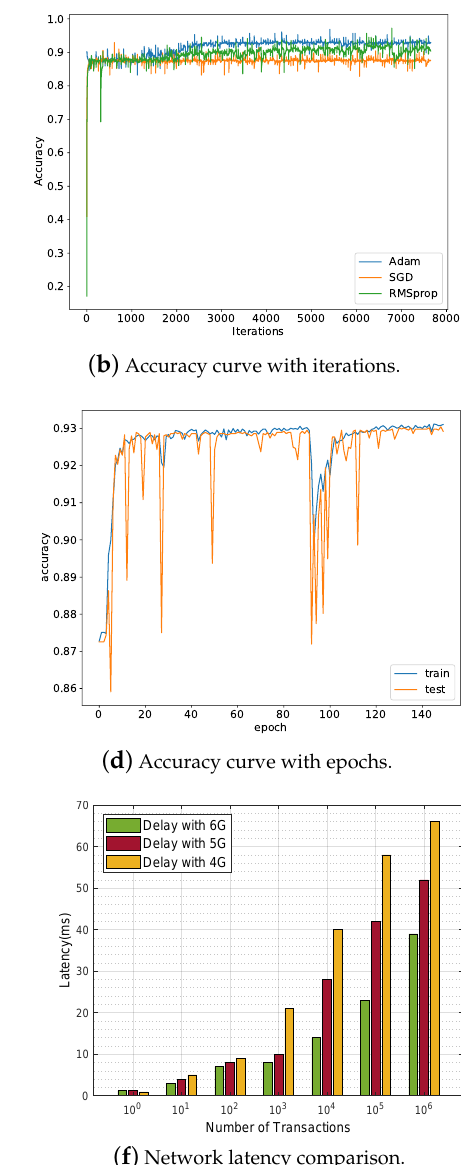
( f ) Network latency comparison. Figure 6. Loss and accuracy curves for different model optimizers during the training process. Scalability and Latency graphs to show the influence of a 6G